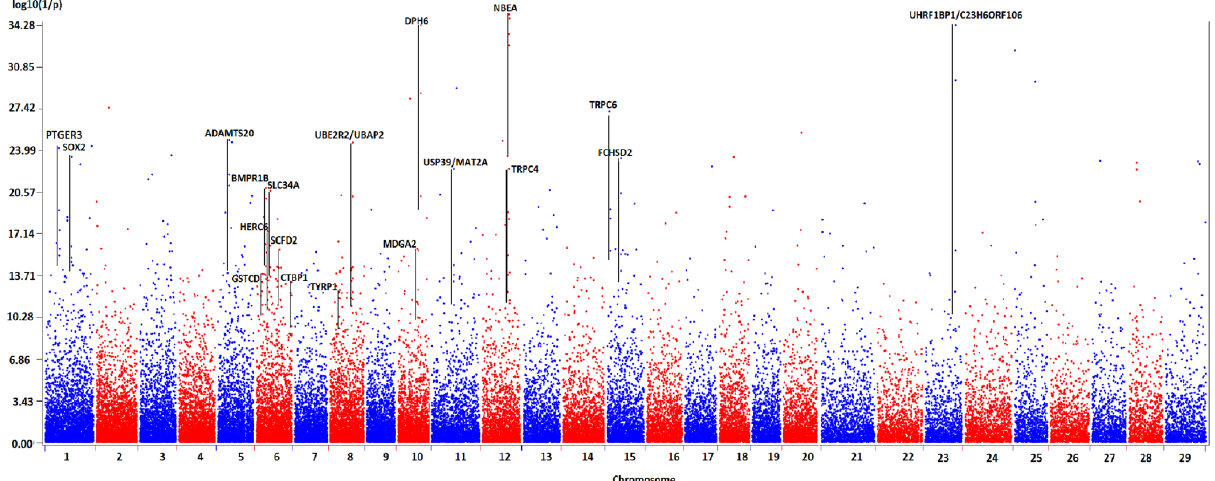
Figure 5. Genome scan for selection signatures in local goat breeds obtained by the LFMM approach and via the cradle method. Each signature was named according to the gene(s) most likely targeted by the selection process, taking into account the distance of the SNPs from the genes, the associated p values and the number of SNPs near or in the